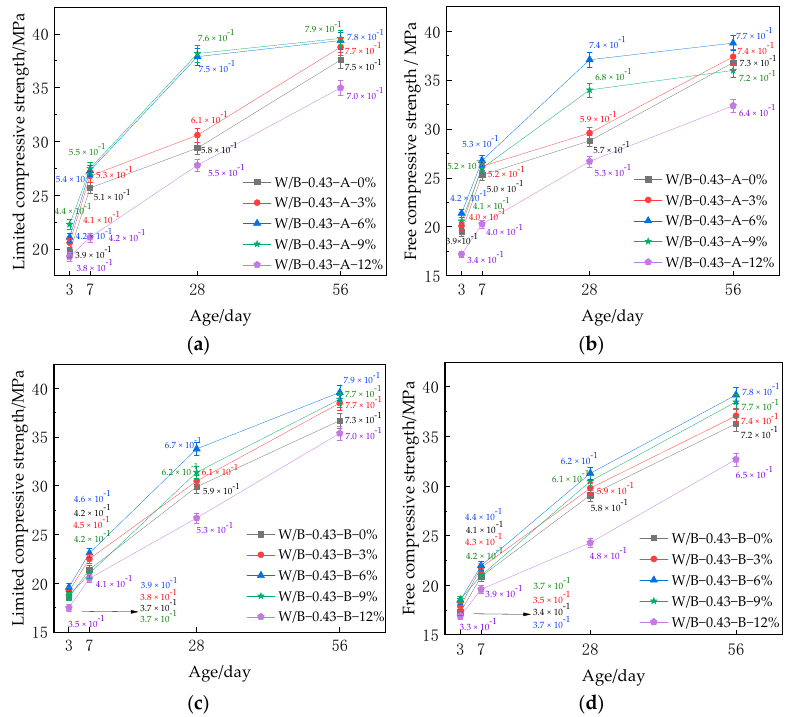
Figure 3. Compressive strength of concrete with water-binder ratio of 0.43. ( a ) Limited strength of group A, ( b ) free strength of group A, ( c ) limited strength of group B, ( d ) free strength of group B.